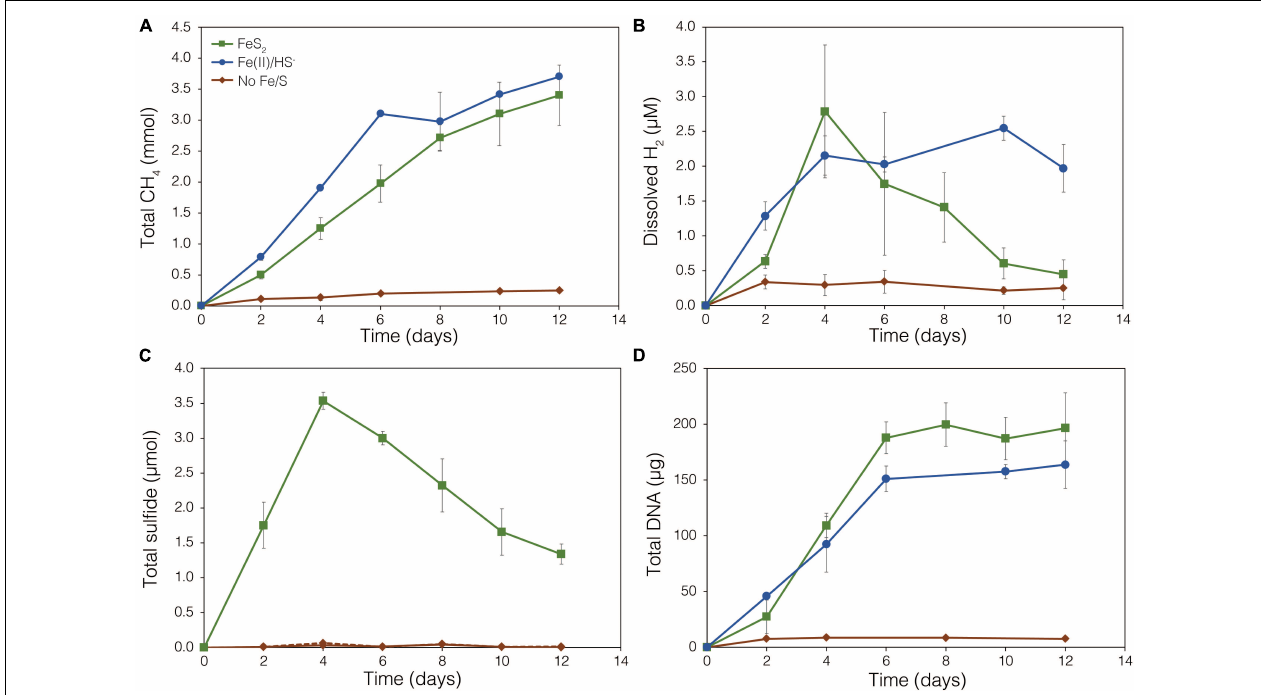
FIGURE 4 | Production of (A) total CH 4 , (B) dissolved H 2 , (C) total sulfide (aqueous plus gas phase), and (D) total biomass (DNA) by Methanosarcina barkeri strain Fusaro during growth with 2 mM synthetic pyrite (FeS 2 ) nanoparticles, 20 µ M ferrous iron [Fe(II)] and 2 mM HS - , or no added Fe or S source (No Fe/S). The H 2 concentration is reported for the dissolved phase. Averages and standard deviations for triplicates are shown. Protein data as an additional proxy for growth is presented in Supplementary Figure 3 . Data depicting growth kinetics and activities of M. barkeri strain MS with FeS 2 are presented in Supplementary Figure 4 .